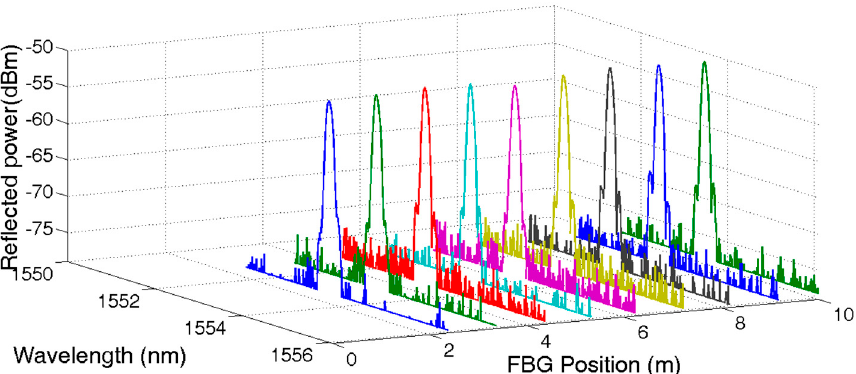
Figure 4. Reflective spectrum of low reflectivity UFBG array.